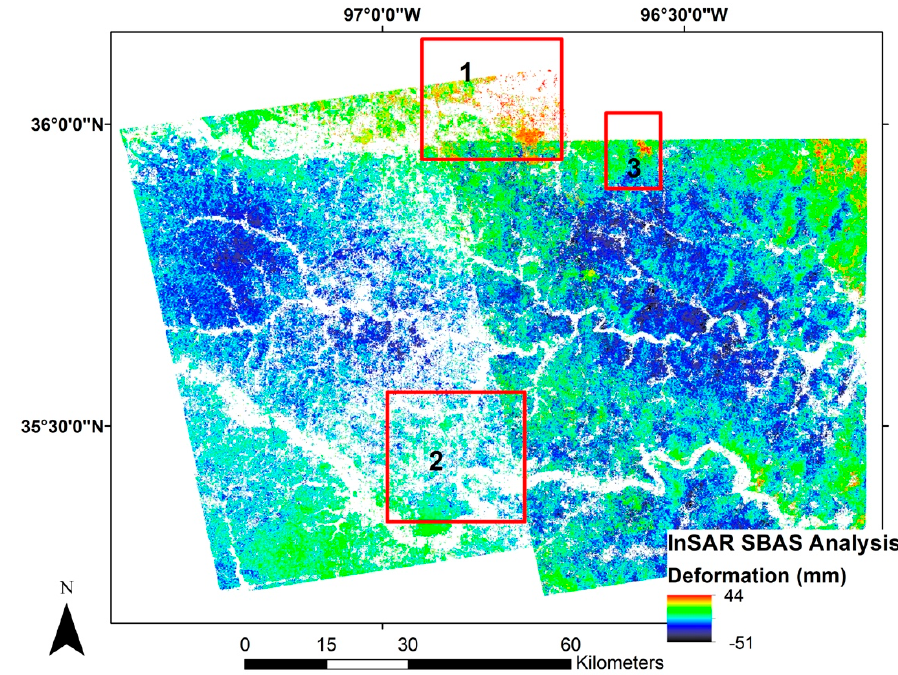
Figure 6. Location of Areas of Interest with relation to regional deformation final map highlighted in red. ( 1 ) City of Cushing, Oklahoma; ( 2 ) Wilzetta Fault Zone; ( 3 ) Area southeast of Drumright, Oklahoma. All deformation is measured in LOS. Negative values represent movement away from the satellite, whereas positive values indicate movement towards the satellite.